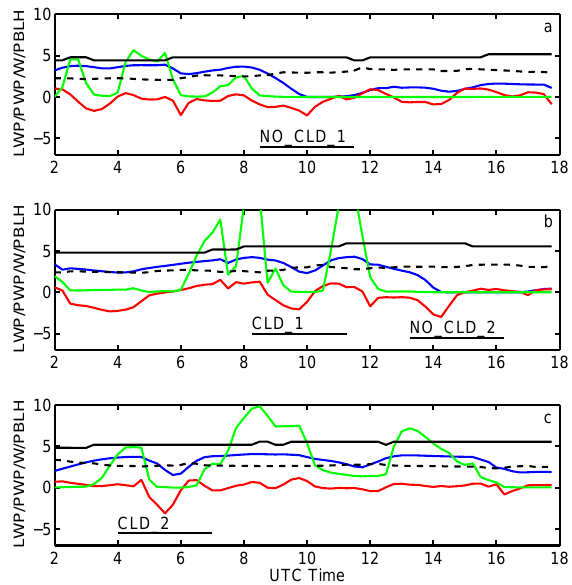
Fig. 9. Evolution in time of LWP (in g m − 2 ) × 0.01 (blue), PWP (in g m − 2 ) q r (green), w int (in cm s − 1 ) (red), inversion height (in m) × 0.005 (black solid), and boundary layer height (in m) × 0.005 (black dashed) for (a) P1 (-79.66,18.62), (b) P2 (-82.32,-18.62), (c) P3 (-82.32,-15.82).